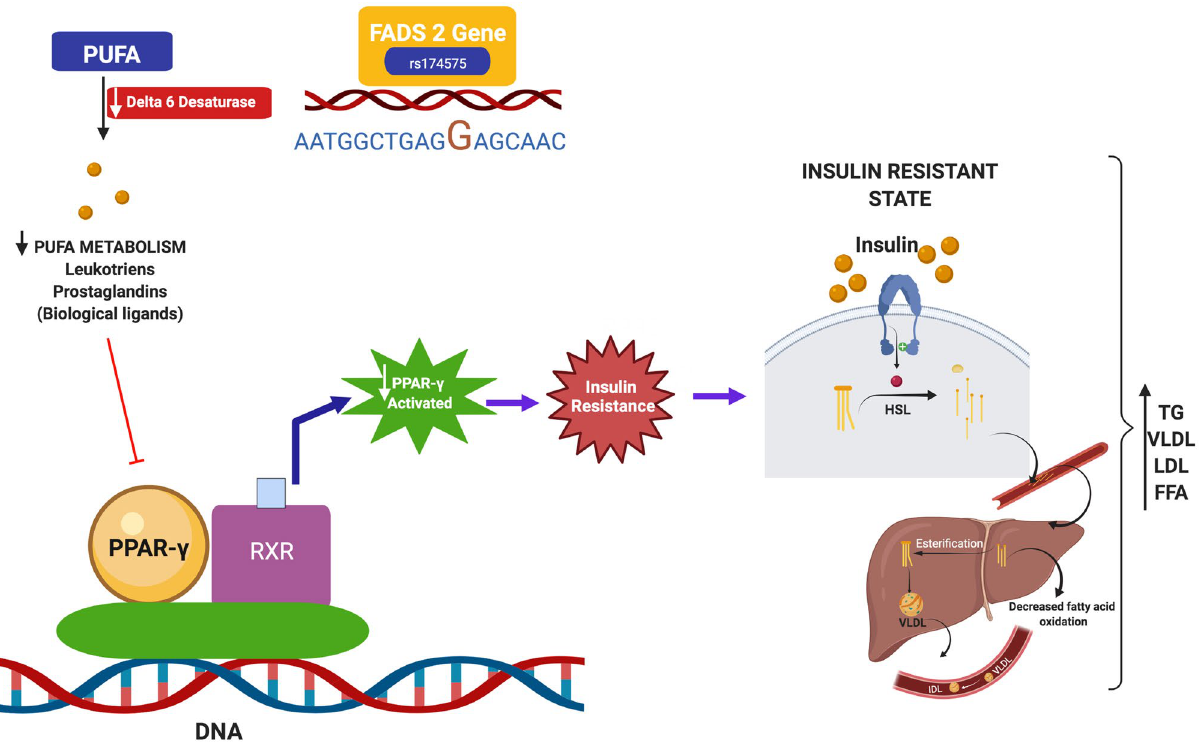
Figure 2. Proposed mechanism showing association between FADS 2 gene polymorphism, lipid levels and type-2 diabetes mellitus.(Created with